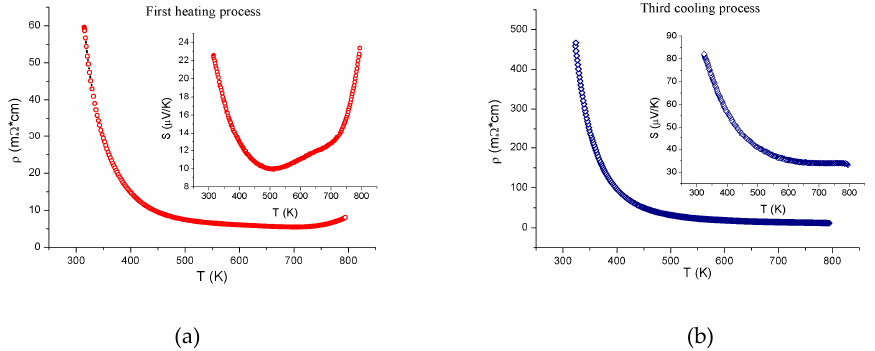
Figure 3. Temperature dependences of ( a ) the resistivity and ( b ) thermopower for three continuous heating-cooling cycles.